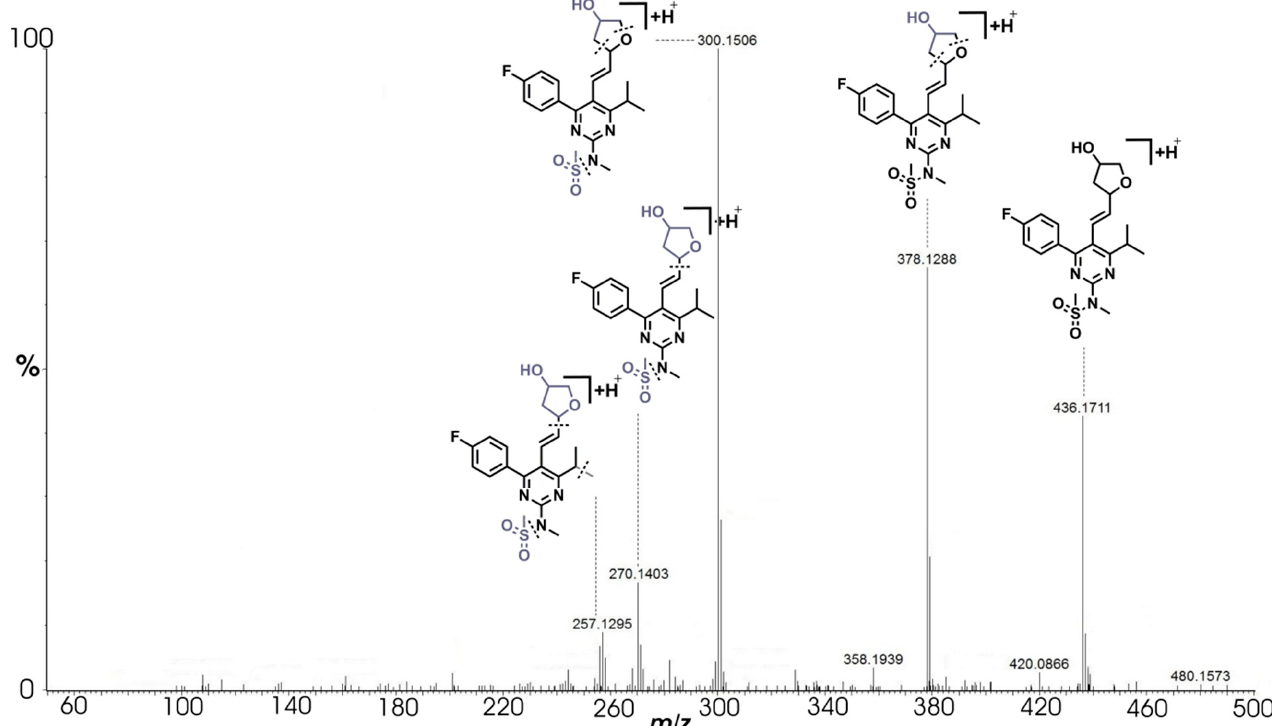
Figure 9. Fragmentation MS/MS spectra of product F [M + H] + ion (product ion mass m/z 436.1711) obtained by using collision energy of 45 V.